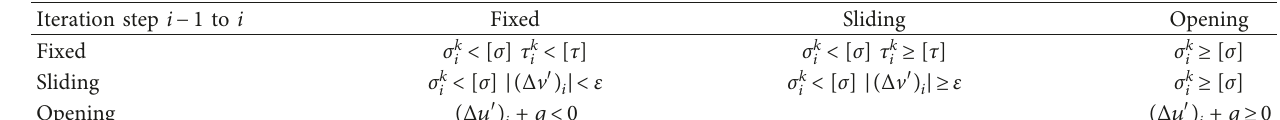
Figure 2: Models of the sliding surface element: (a) FE mesh model; (b) traditional joint model; (c) COJO element. Table 1: Contact states of COJO elements.